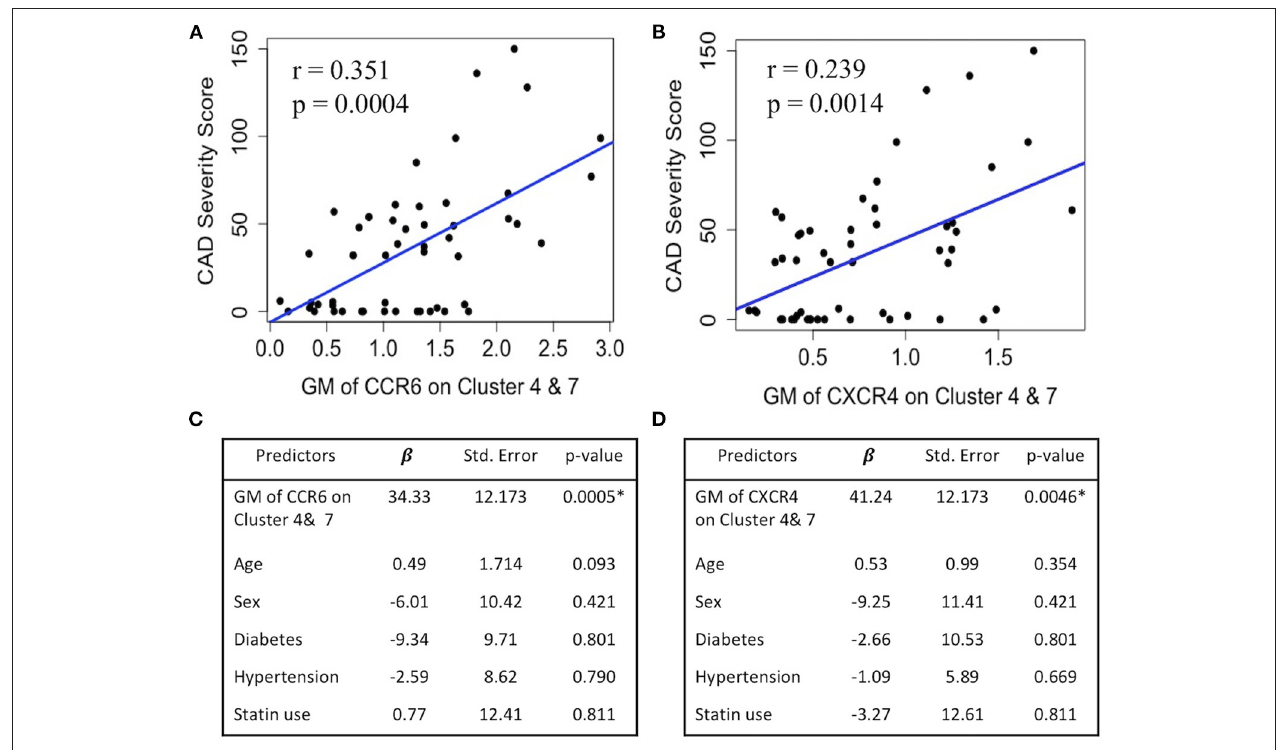
FIGURE 8 | CXCR4 and CCR6 expression on SWM B cells directly associates with CAD severity. (A,B) Linear regression between GM of CCR6 (A) and CXCR4 (B) on cluster 4 and 7 and CAD Gensini severity score. (C,D) Multivariate regression between GM of CCR6 (C) and CXCR4 (D) on cluster 4 and 7 and CAD Gensini severity score with age, sex, diabetes status, hypertension and statin use as covariates. * p < 0.05 by Mann-Whitney test.